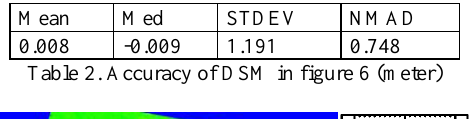
Table 2. Accuracy of DSM in figure 6 (meter)